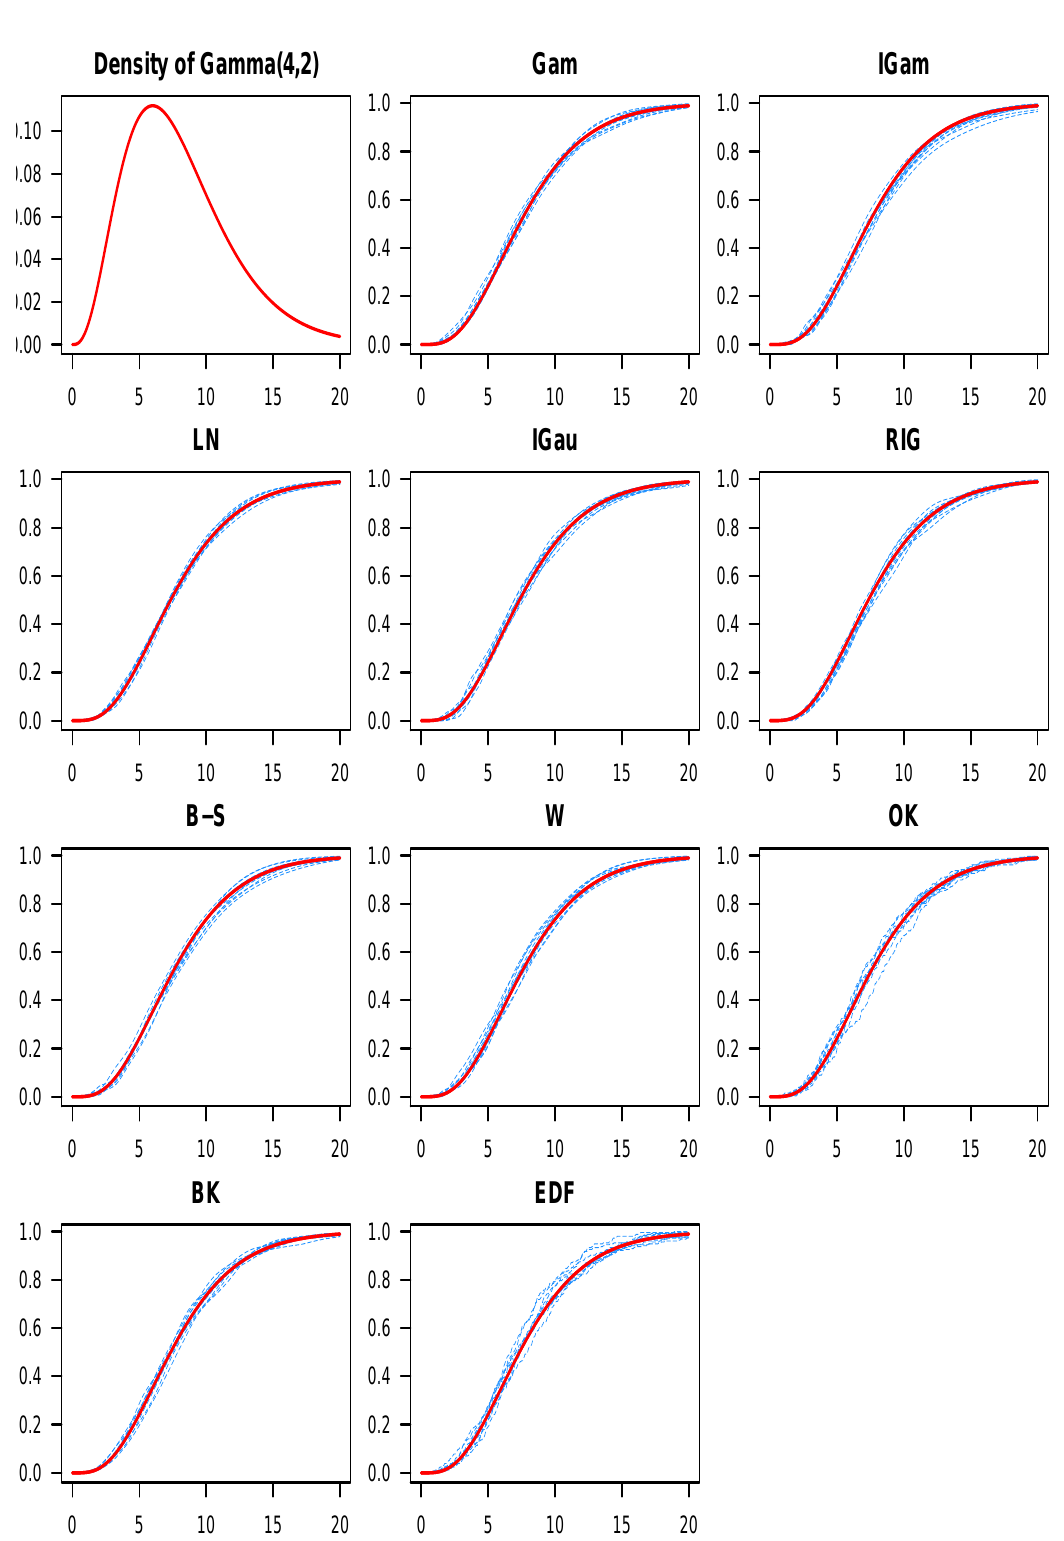
Figure 4. The Gamma ( 4,2 ) density function appears on the top-left, and the target c.d.f. is depicted in red everywhere else. Each plot has ten estimates in blue for the Gamma ( 4,2 ) c.d.f. using one of the ten estimators (the name of the corresponding kernel is indicated above each graph) and n =